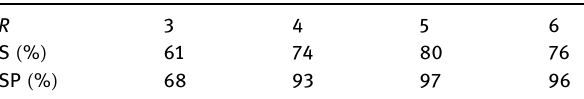
stretched at various elongation ratios ( T p = 40°C